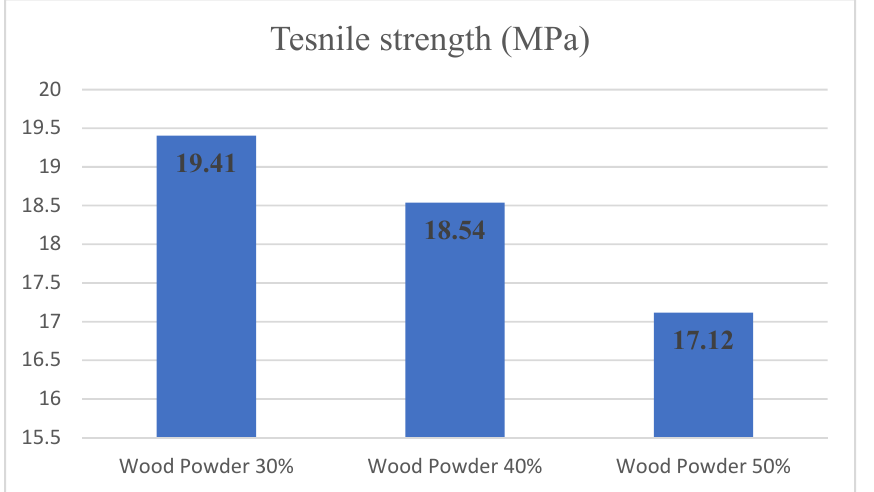
Figure 6. Tensile strength comparison according to a different amount of wood powder and 0% nanoclay.